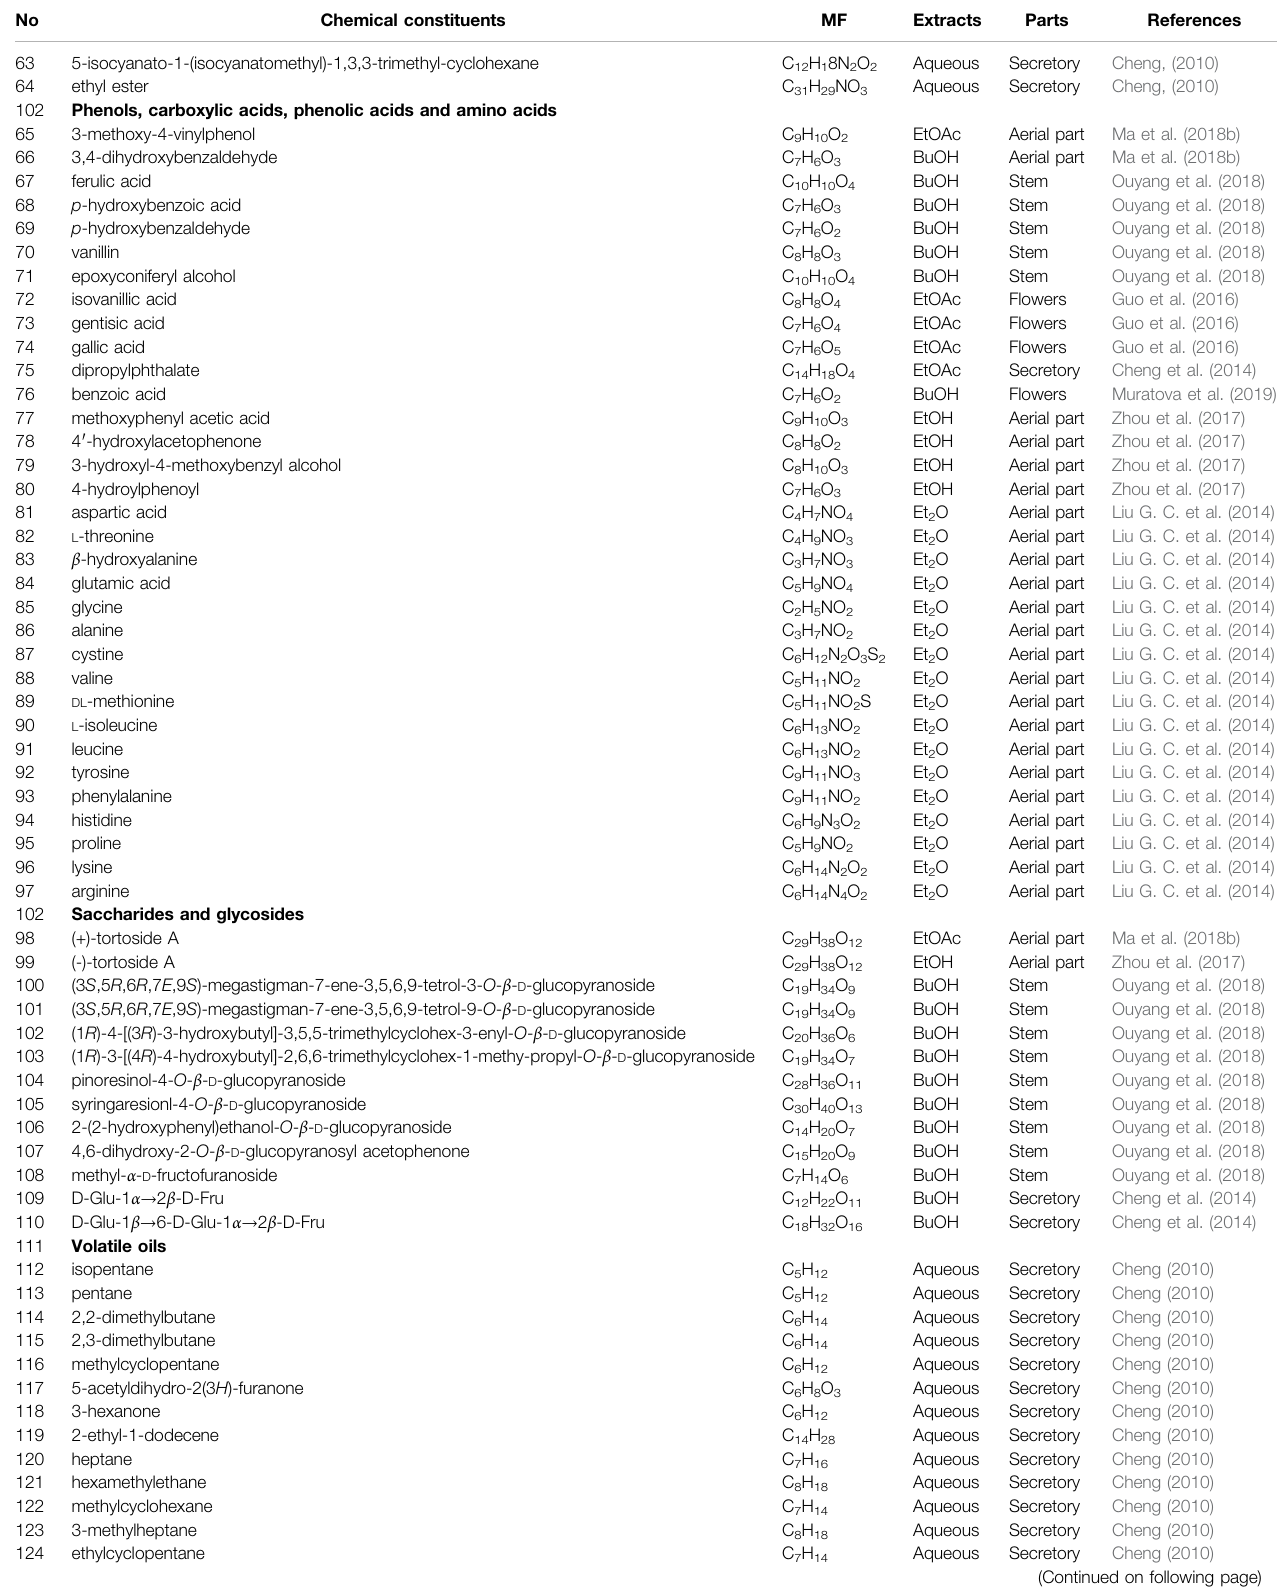
TABLE 2 | ( Continued ) Chemical components isolated and structurally identi fi ed from A. sparsifolia (MF (cid:2) Molecular